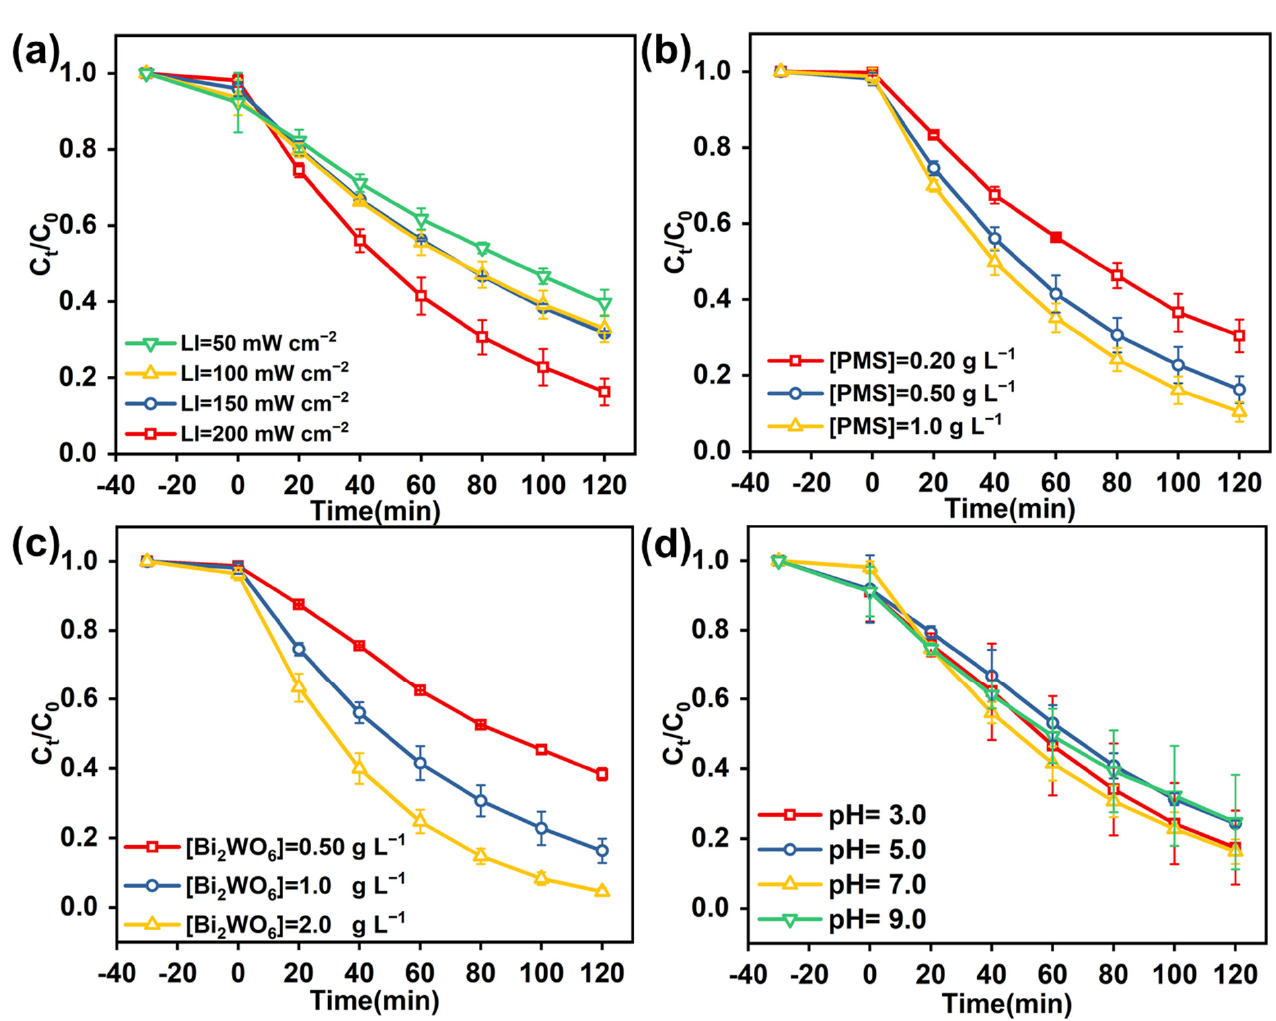
Figure 4. Effects of LI ( a ), effects of Bi 2 WO 6 dosage ( b ), effects of PMS concentration ( c ), and effects of initial pH ( d ) on CBZ degradation in the VL/Bi 2 WO 6 /PMS process. Experimental conditions: LI = 50–200 mW cm − 2 , Bi 2 WO 6 dosage = 0.50–2.0 g L − 1 , [PMS] 0 = 0.20–1.0 g L − 1 , [CBZ] = 10.0 mg L − 1 , pH = 3.0–9.0, and T = 25 °C.